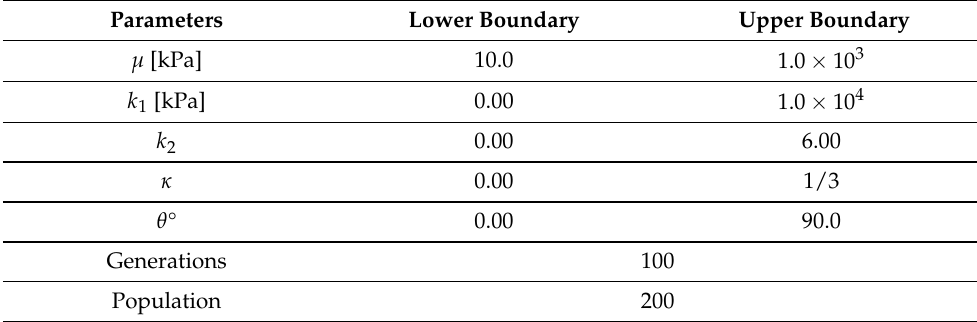
Table 4. ES parameters to characterize a GHO model with finite elements.